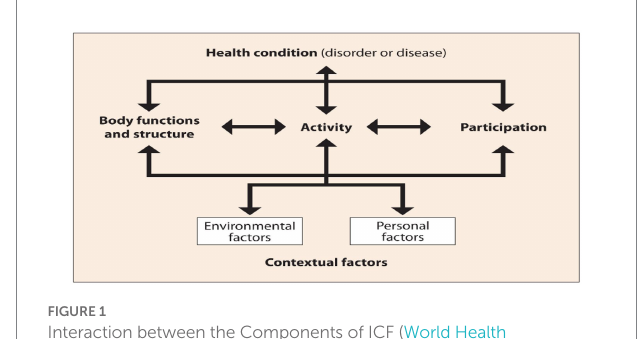
FIGURE 1 Interaction between the Components of ICF (World Health Organization,